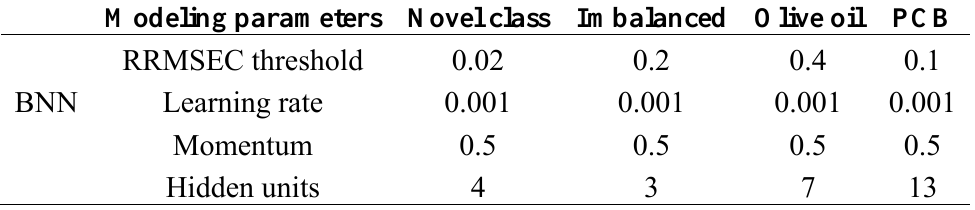
Table 4. The modeling parameters of the ANNs, PLS-DA, SVM, and RF method. Hidden units are the number of hidden units in the trained network model. Latent variables are the number of latent variables used in the PLS-DA models. The RBF kernel parameter is denoted by γ in the SVM method. Mtry is the number of variables to split on at each node in the RF